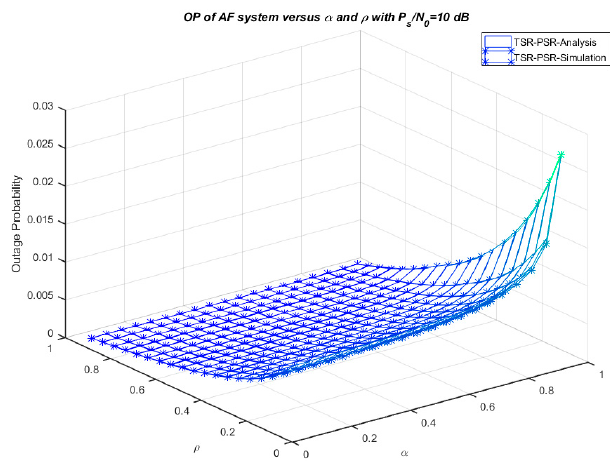
Sensors 2018 , 18 , x Figure 7. Outage probability versus ρ and α . Figure 7. Outage probability versus ρ and α .